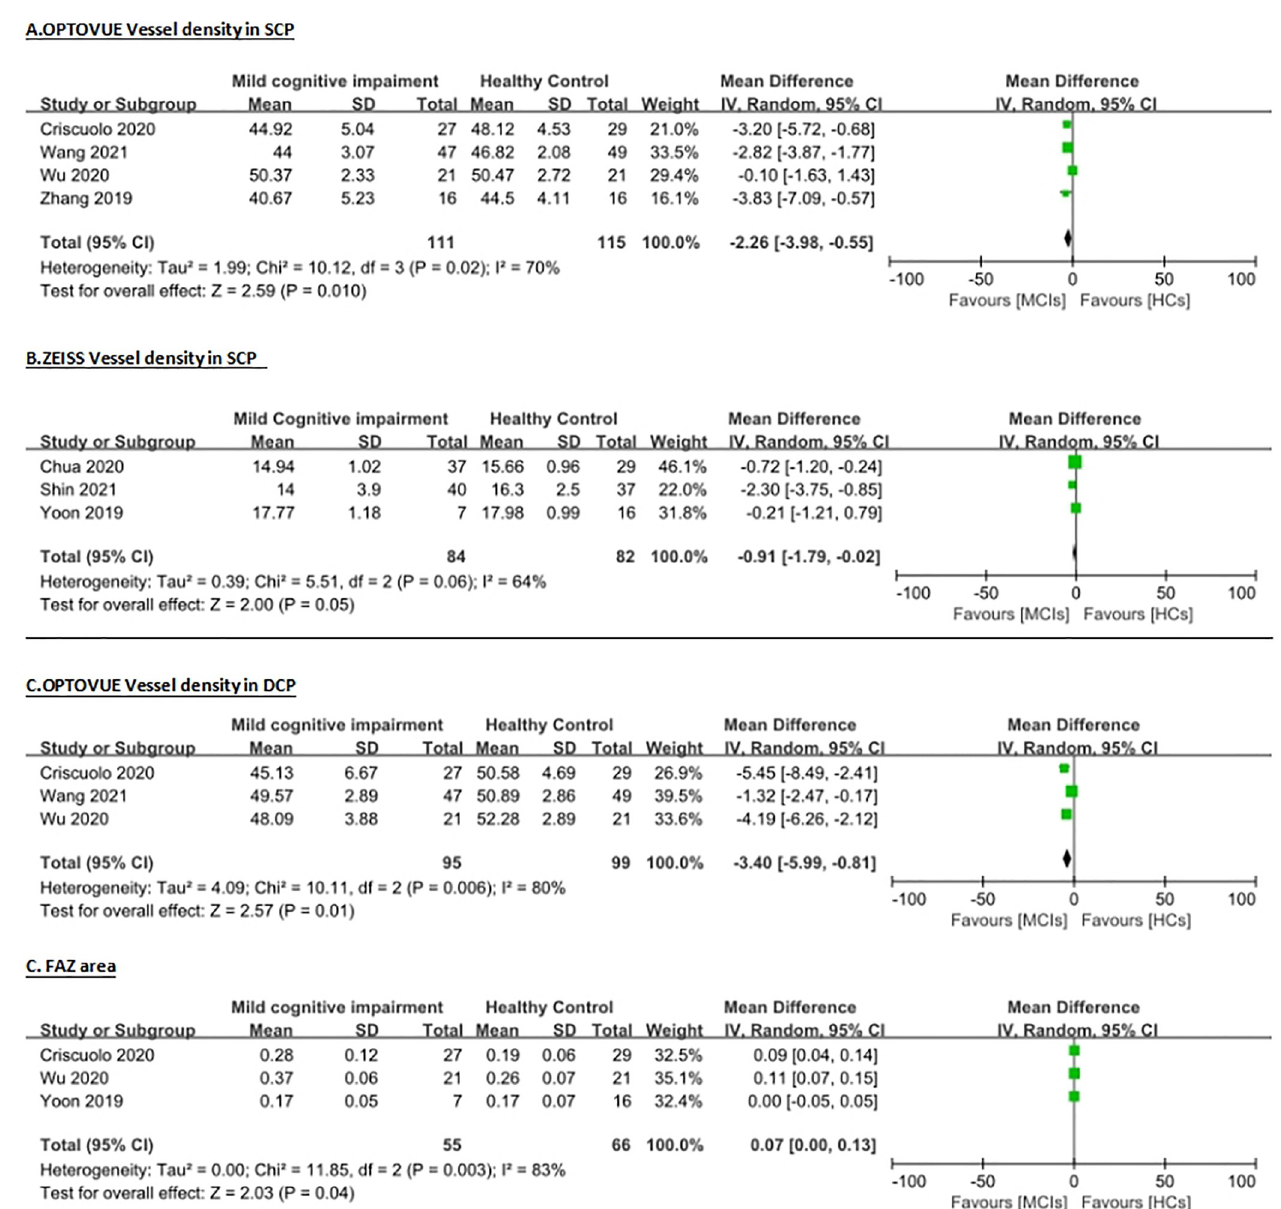
Fig 2. Meta-analysis of vessel density (VD) for mild cognitive impairment patients versus healthy controls. Mean and standard deviation (SD) are included, with 95% confidence intervals (CIs), heterogeneity scores and overall effect in an inverse variance (IV) random effects model. The green square size represents the weight attributed to each study based on relative sample size. (A) VD in superficial capillary plexus (SCP) detected by Optovue. (B) VD in SCP detected by Zeiss. (C) VD in deep capillary plexus (DCP) detected by Optovue. (D) Area size of foveal avascular zone (FAZ) in mm2.